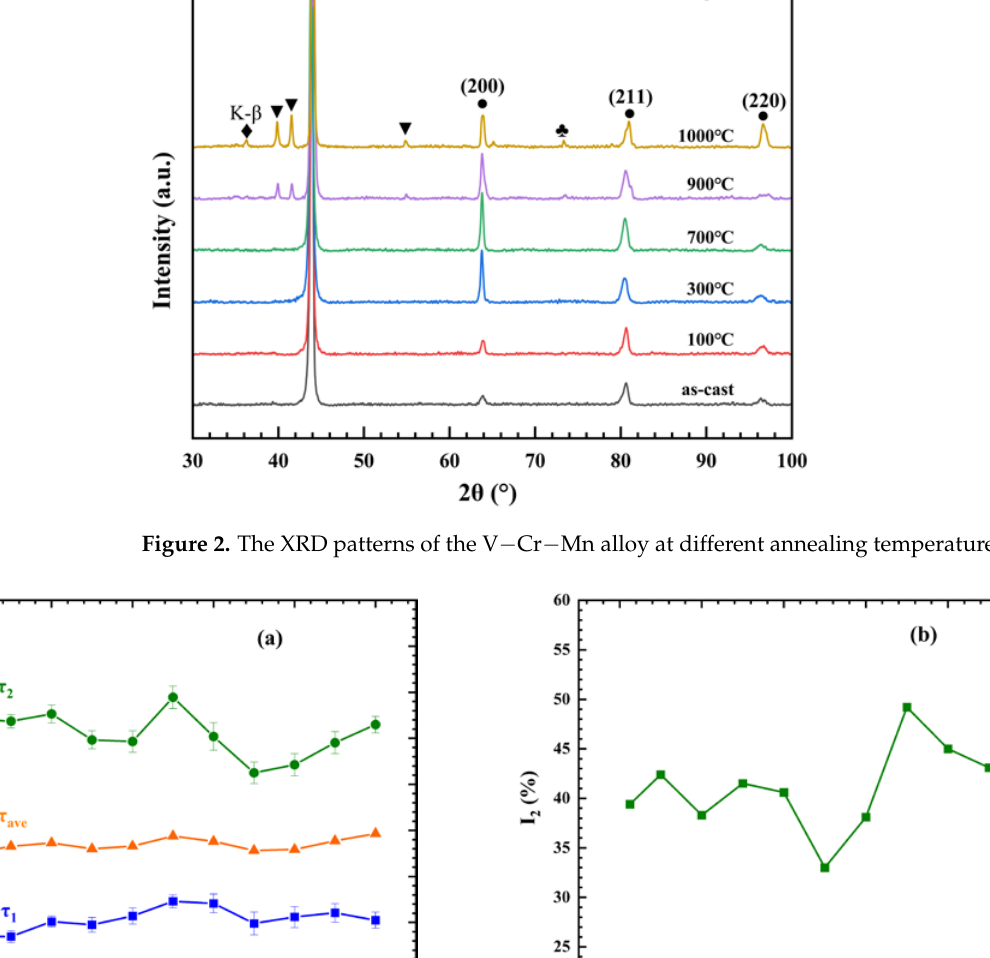
Figure 2. The XRD patterns of the V−Cr−Mn alloy at different annealing temperatures.